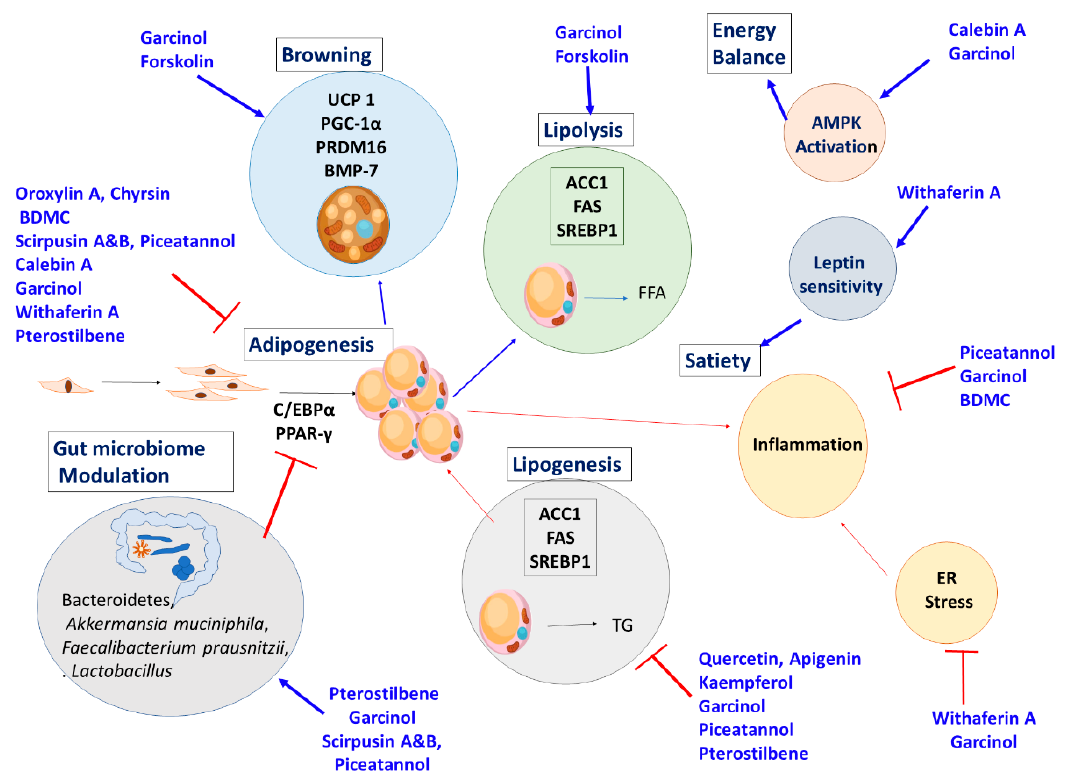
Figure 10. Molecular pathways modulated by the active ingredients in modulating and regulating the obesity related genes and pathways. ( ┴ ) Inhibited; (